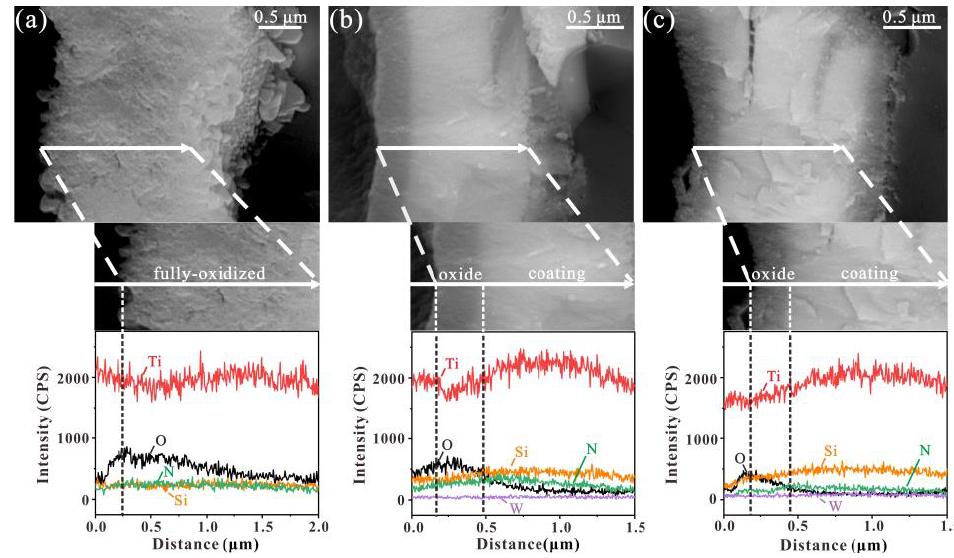
Figure 9. SEM cross-sectional morphologies and EDX line-scan results of ( a ) Ti 0.88 Si 0.12 N, ( b ) Ti 0.88 Si 0.08 W 0.04 N, and ( c ) Ti 0.84 Si 0.09 W 0.07 N coatings after oxidation at 750 °C for 10 h.